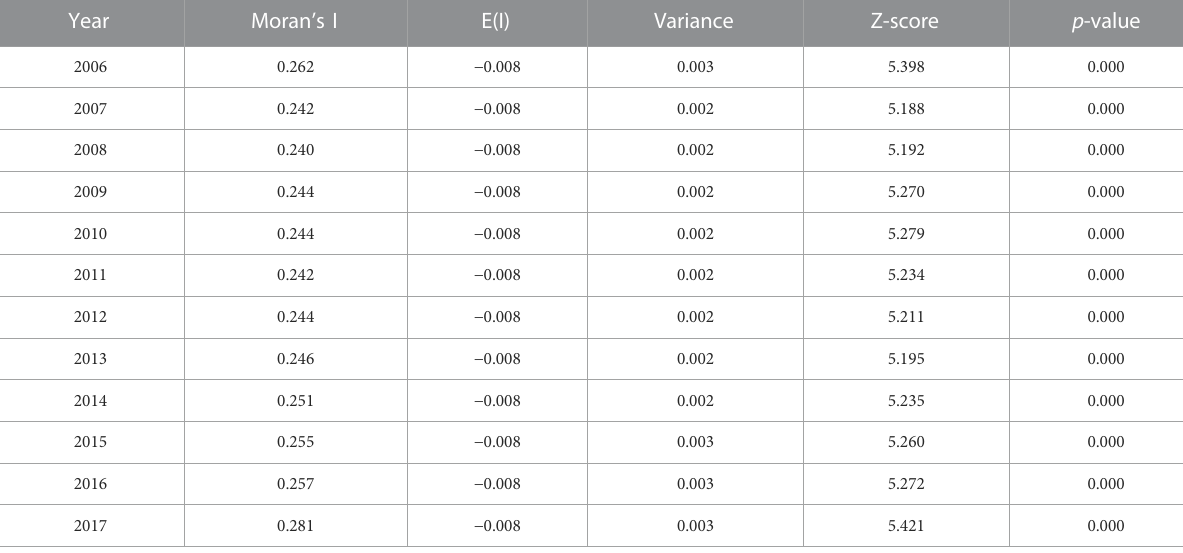
TABLE 3 Spatial autocorrelation index of GDP in the 13 provinces of North China between 2006 and